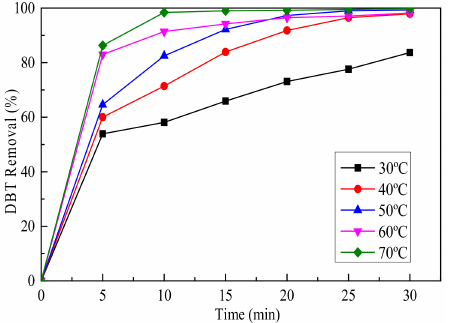
Figure 9. Effects of reaction temperature on removal of DBT.